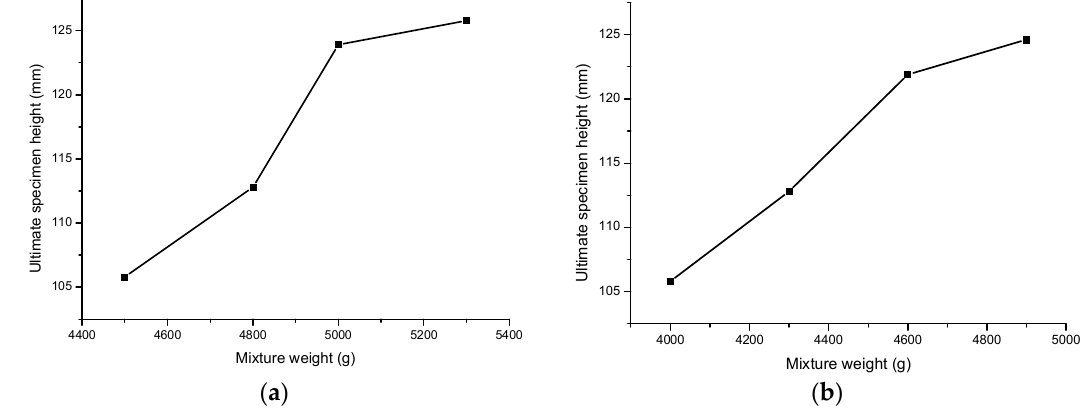
Figure 6. Variation of ultimate specimen height with mixture weight: ( a ) Aggregate A; ( b ) Aggregate B.